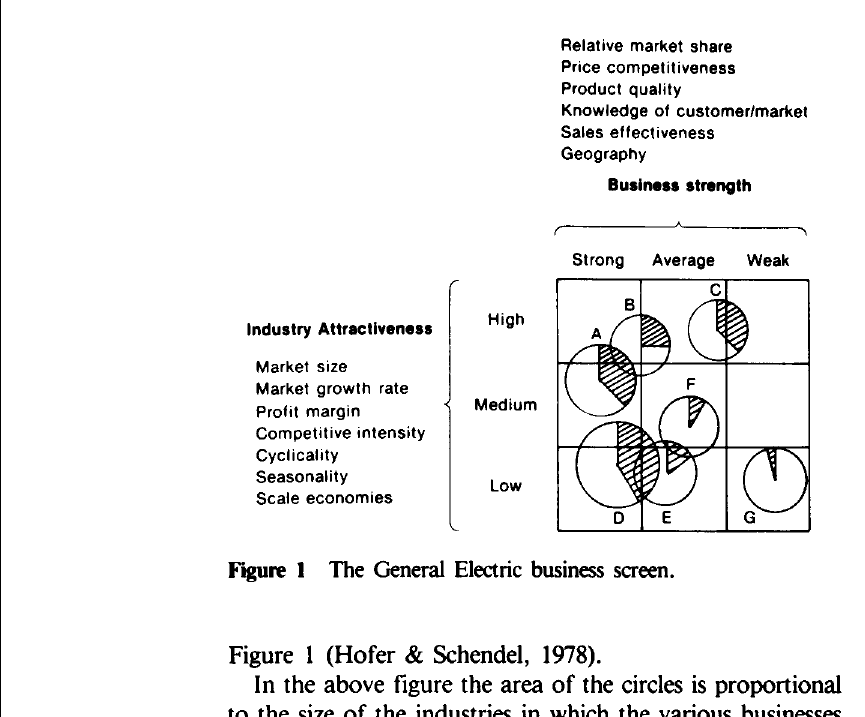
Figure 1 (Hofer & Schendel, 1978).